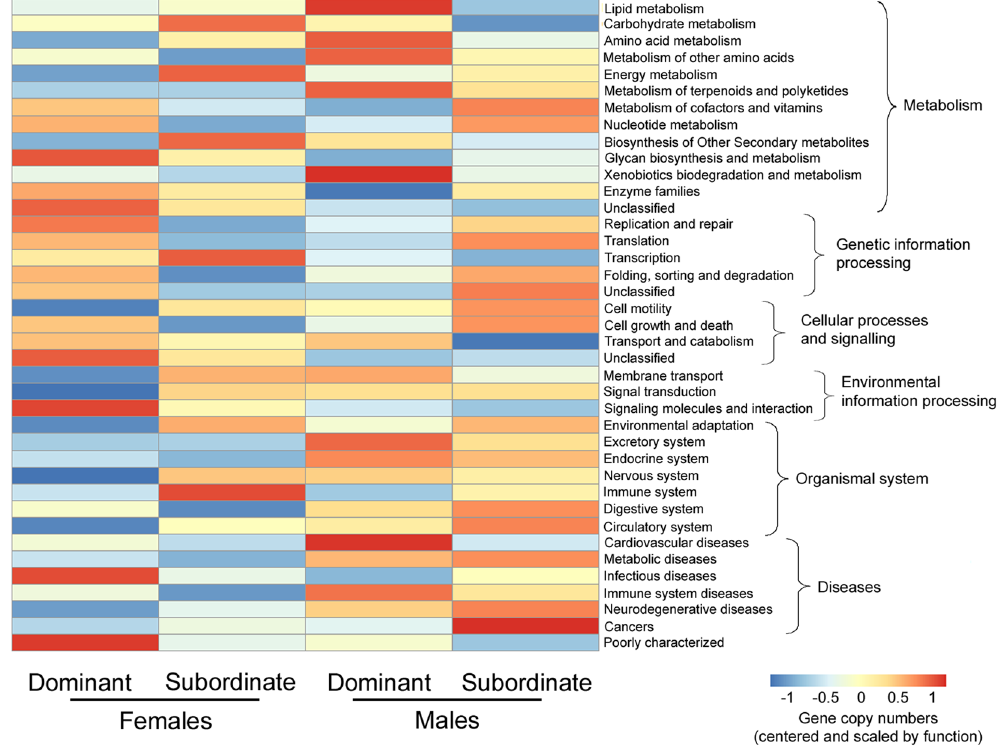
Figure 6. Predicted functions of microbiota in meerkat paste and how they might differ between dominant and subordinate males and females. KEGG pathway of the second levels is shown in the heatmap.